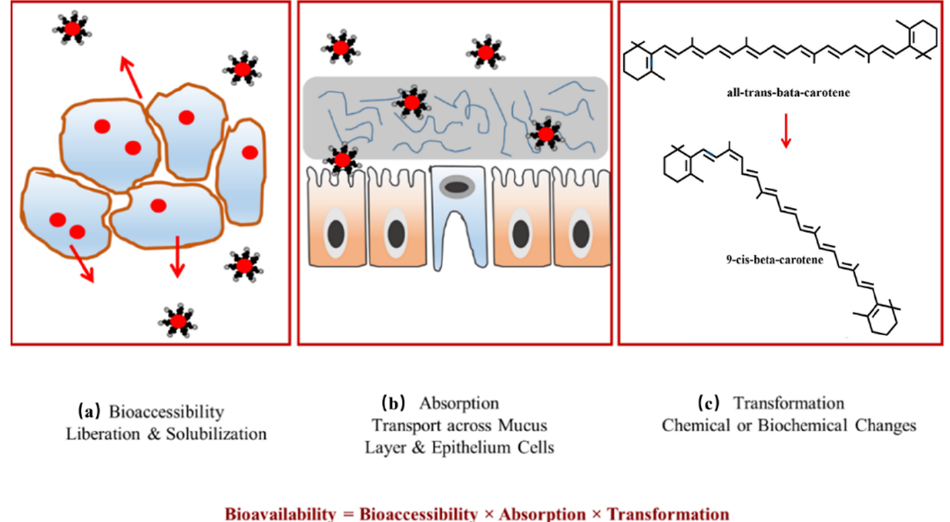
Figure 1. The overall oral bioavailability of bioactives is governed by three main factors: ( a ) bioaccessibility; ( b ) absorption and ( c ) transformation. Reproduced with permission from ref. [9]. Copyright 2016 by MDPI.